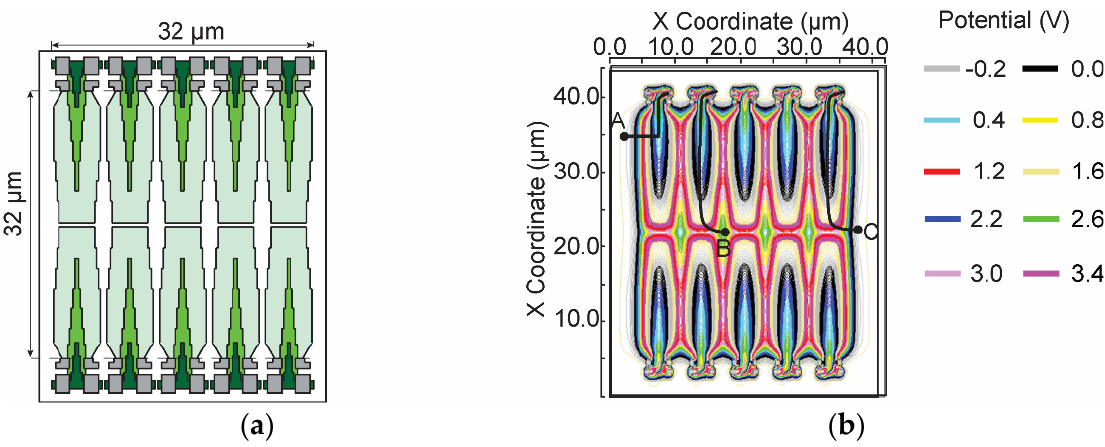
Figure 5. LEFM photo ‐ demodulator. ( a ) Large area implementation with the combination of ten sub ‐ structure LEFM photo ‐ demodulator. ( b ) Simulation of photo ‐ charges time transfer from three locations (A, B, and C) to evaluate charge transfer speed for large area LEFM photo ‐ demodulator. Table 1. Photo ‐ charges transfer time simulations for the large area LEFM photo ‐ demodulator. Initial